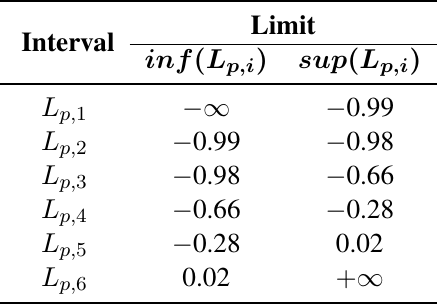
Table 4. Example of a discretization matrix.